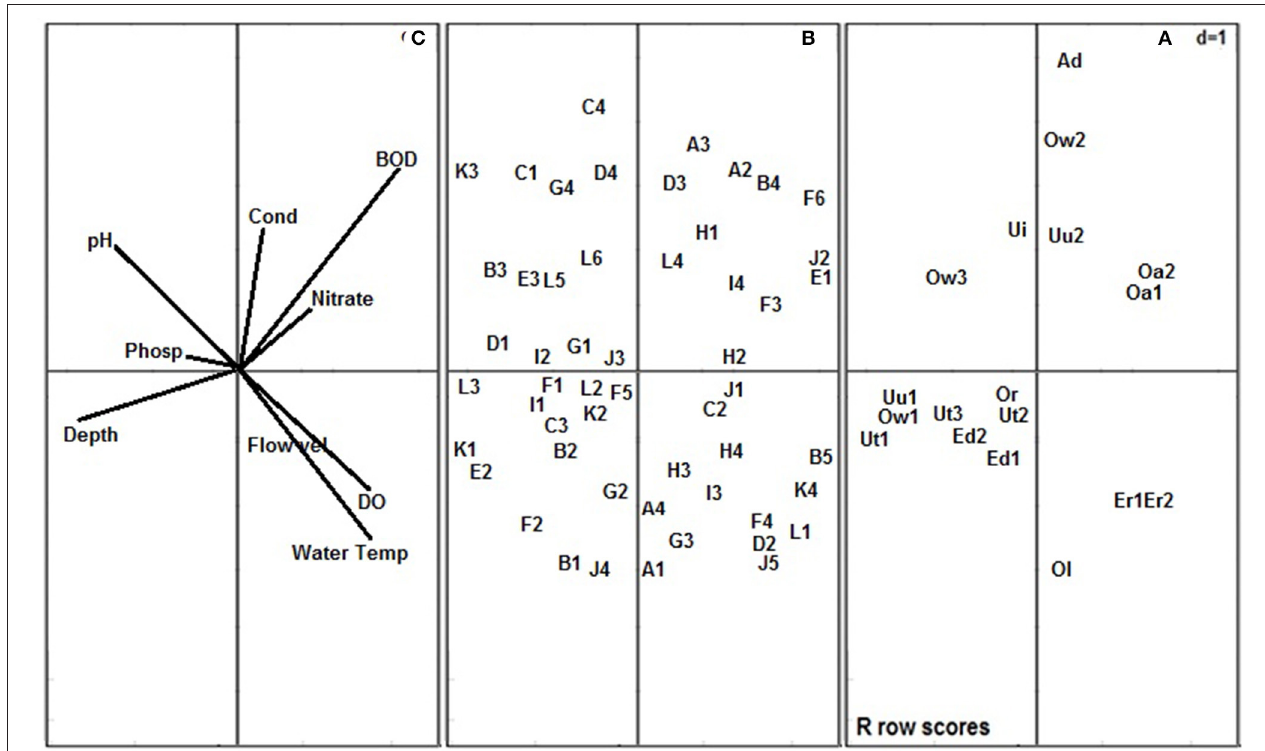
FIGURE 3 | Co-variation of the 18 river stations (A) , macroinvertebrate traits (B) and physico-chemical variables (C) along the first two components of the RLQ. Stations: Uu1, Umu River Station 1; Uu2, Umu River Station 2; Ut1, Utor River Station 1; Ut2, Utor River Station 2; Ut3, Utor River Station 3; Ed1, Edor River Station